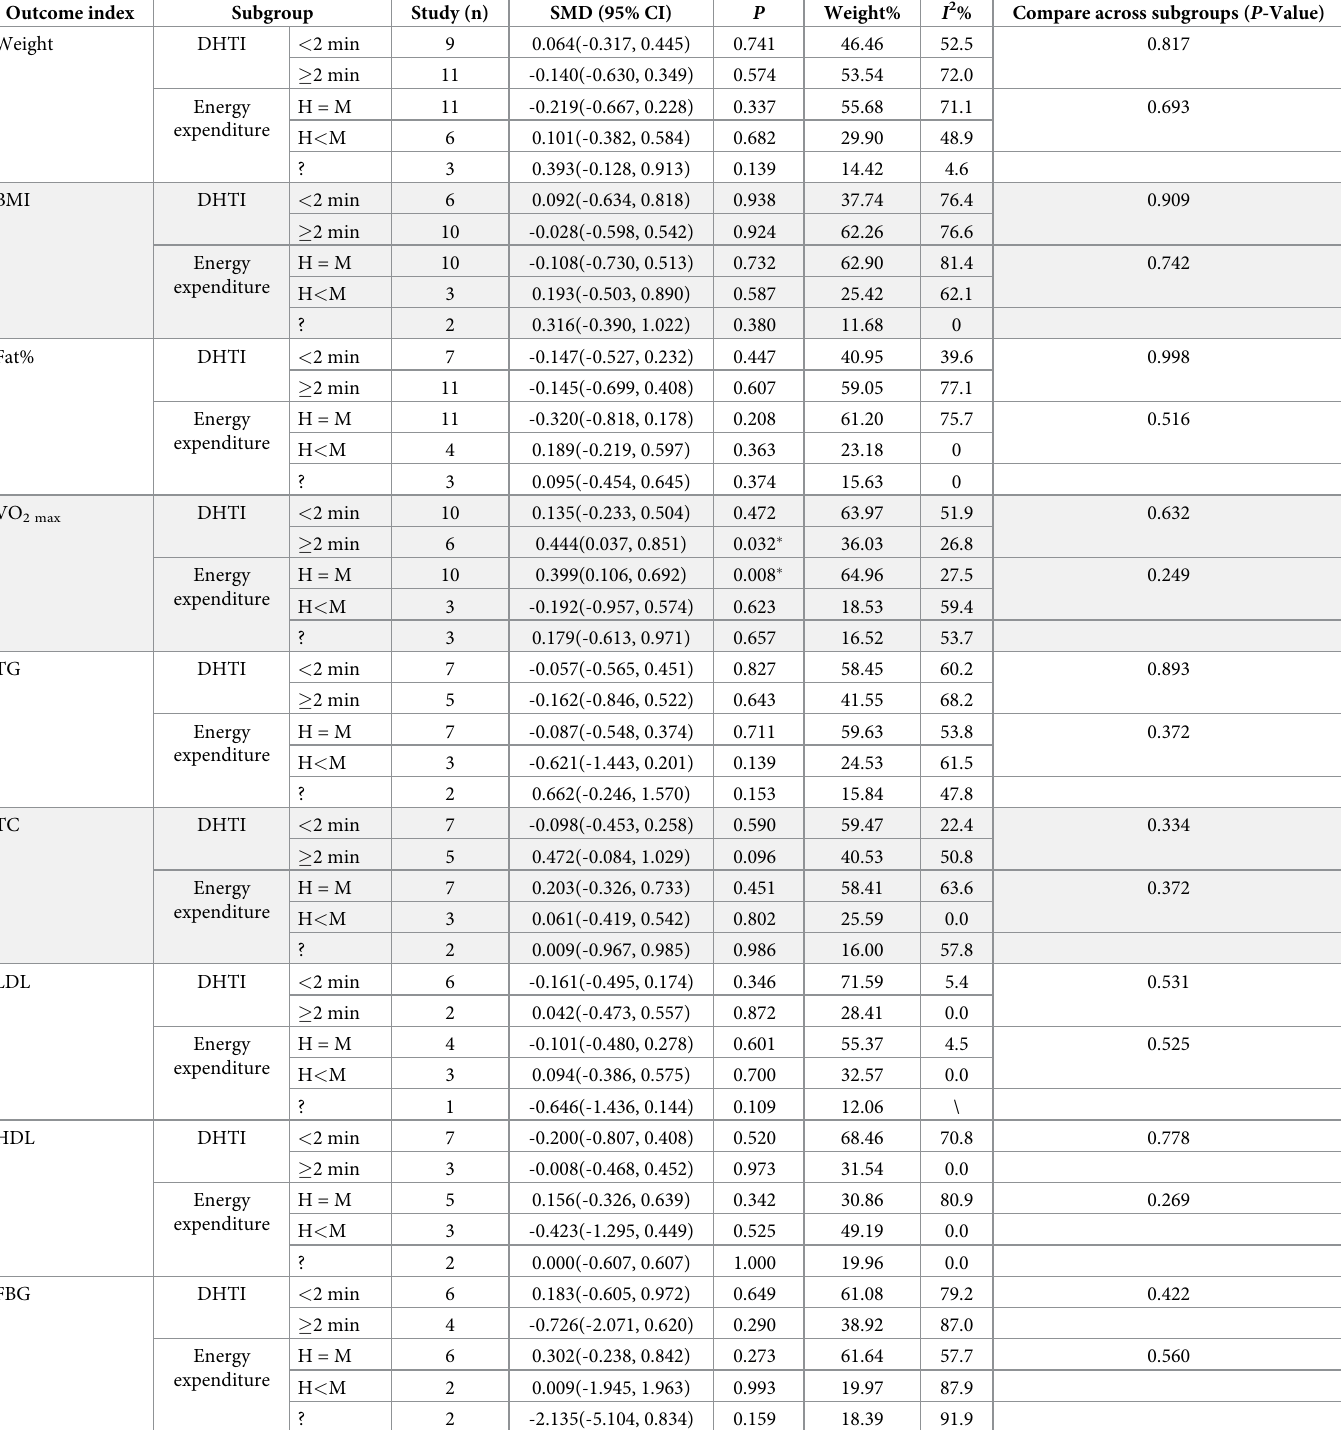
Table 4. Results of subgroup